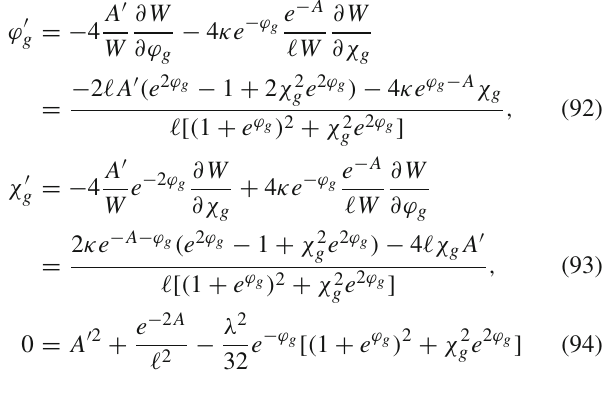
setting ϕ 1 , 2 = χ 1 , 2 = 0. By using the phase (90) in δχ i =